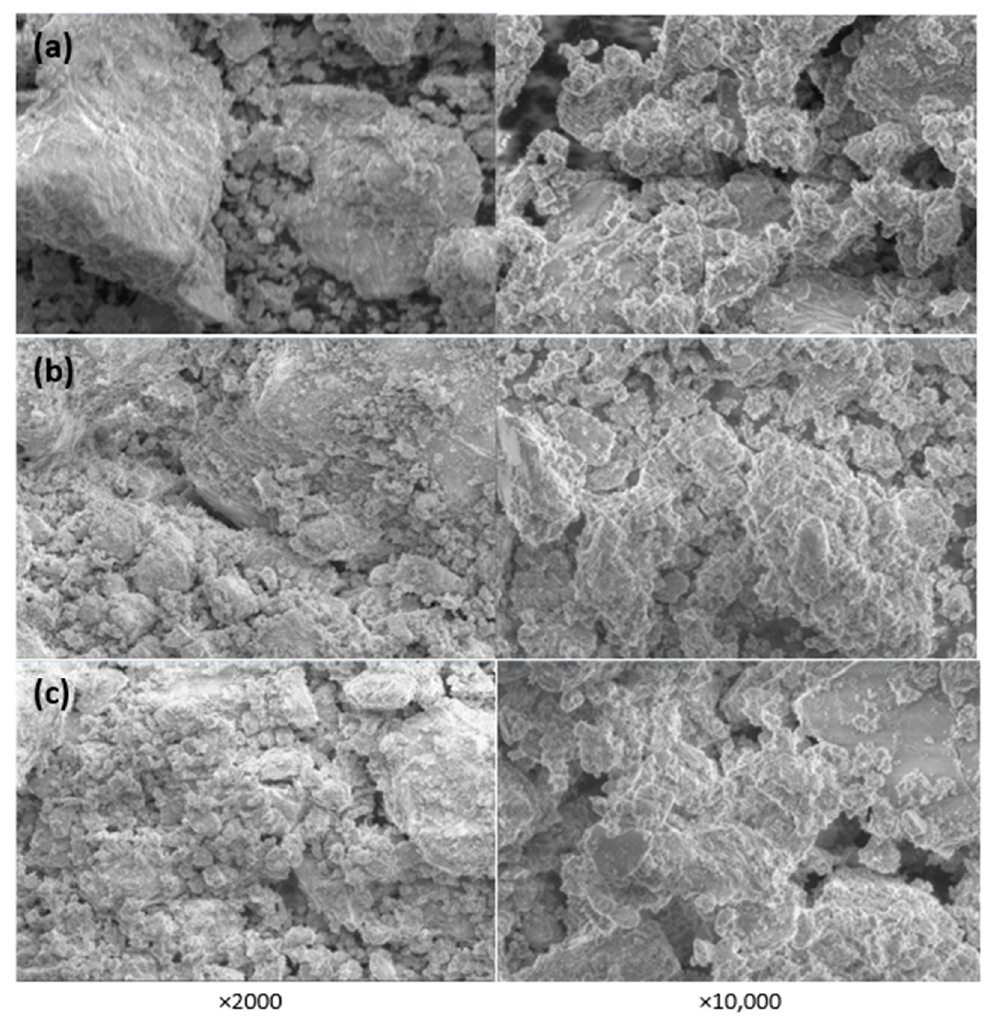
Figure 8. SEM images of cement stone: ( a ) with no concrete sludge, ( b ) with 10% cement replaced with dry concrete sludge, ( c ) with 10% cement replaced with wet concrete sludge.